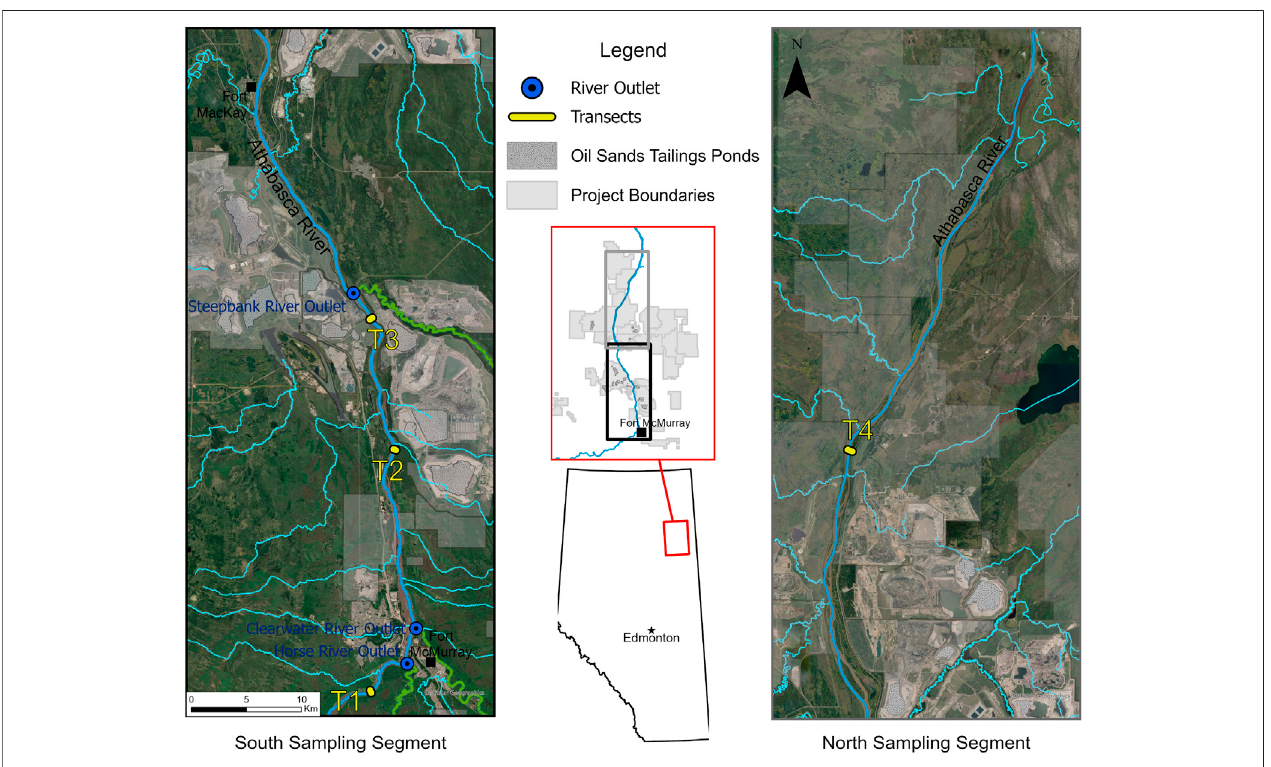
FIGURE 1 | Sampling sites along the lower Athabasca River (LAR), northern Alberta.